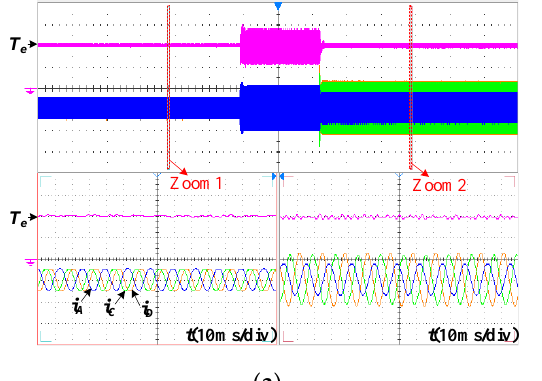
Figure 11. Experimental results in normal operation, fault operation, and two-phase open-circuit fault-tolerant operation. (2 Nm/div, 5 A/div). ( a ) BE two-phase open-circuit fault. ( b ) CD two-phase open-circuit fault.